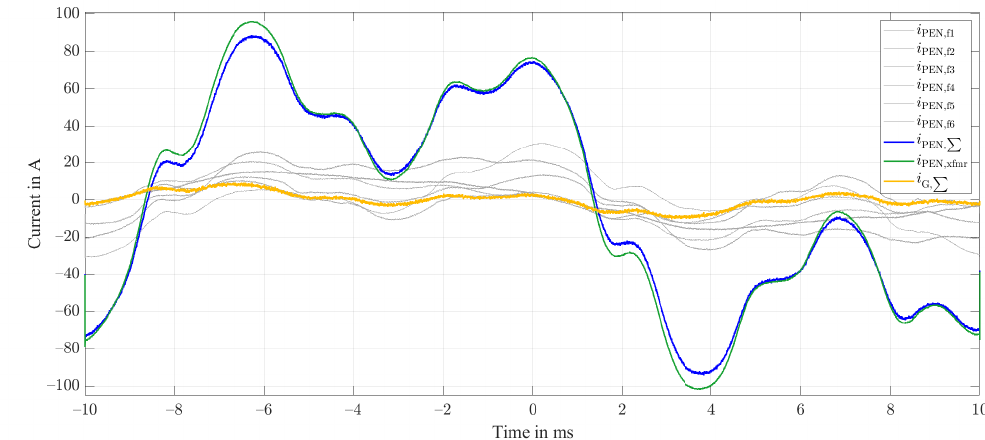
Figure 4. Measurement of ground/neutral currents at LV PEN busbar of substation